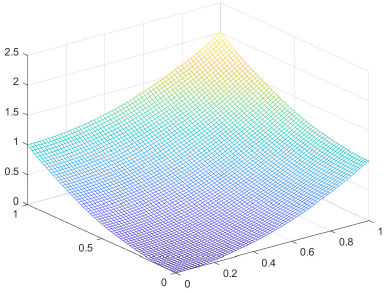
Figure 5. exact solution u = x 2 + y 2 Figure 6. numerical solution u h of B.C. I Figure 5. Exact solution u = x